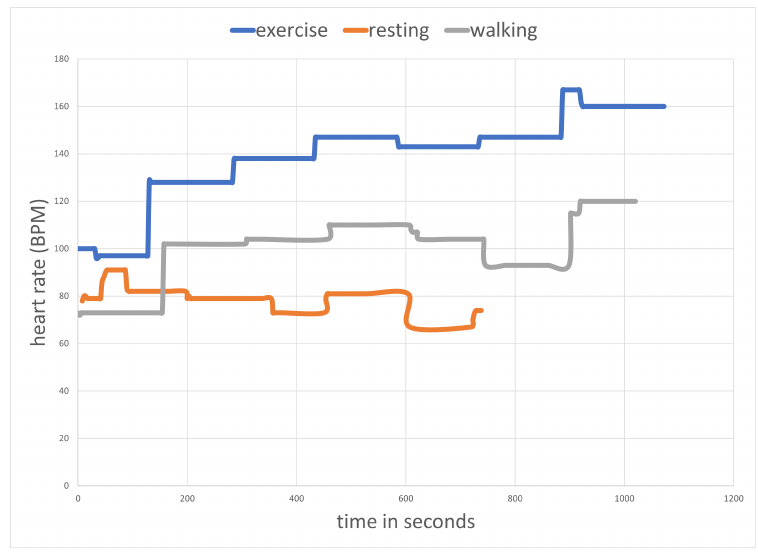
Figure 2. Example of heart rate